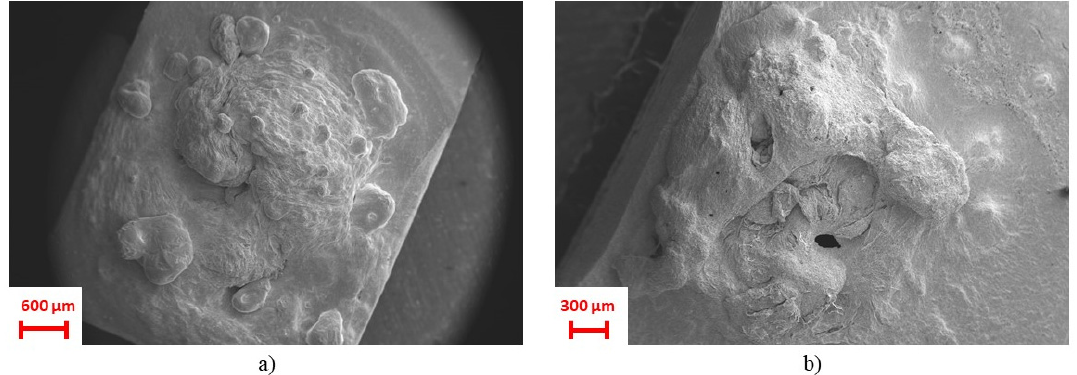
Figure 3. Top view of the drops for samples ( a ) Fe63_SPS and ( b ) Fe50_SPS in contact with the AgCuIn alloy.